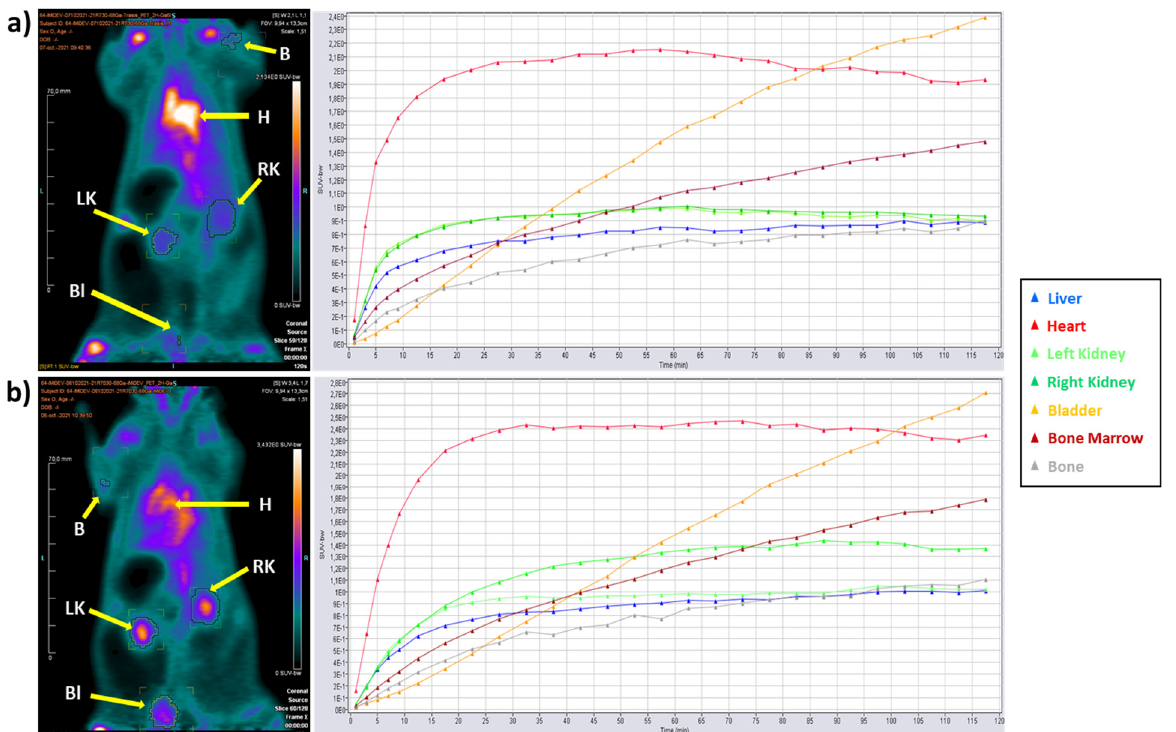
Figure 6. Dynamic µPET imaging of [ 68 Ga]Ga-citrate up to 120 min post injection (coronal slice; injected dose: 26.7 ± 0.5 MBq; scan duration: 5 frames of 2 min and 22 frames of 5 min); ( a ) PET image and time activity curve (TAC) of [ 68 Ga]Ga-citrate synthesized on mAIO ® ; ( b ) PET image and TAC of [ 68 Ga]Ga-citrate synthesized on iMiDEV ™ . B: bone; H: heart; LK: left kidney; RK: right kidney; Bl: bladder.